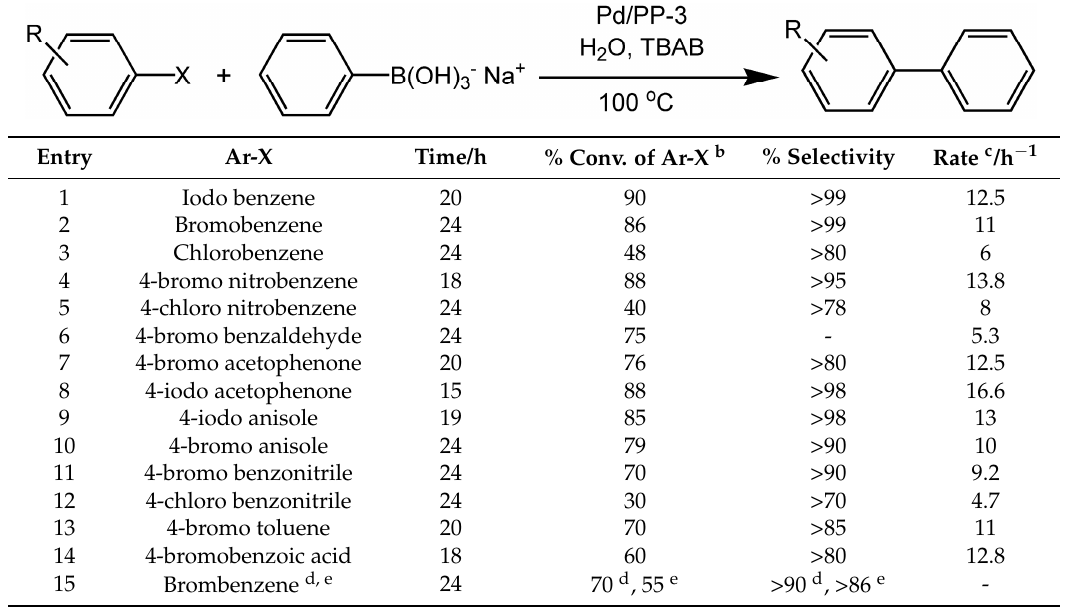
Figure 5. ( a ) Influence of reaction temperature; ( b ) Amount of catalyst on yield of biphenyl from bromobenzene; ( c ) Reaction profile/kinetic plot for bromoenzene conversion to biphenyl; ( d ) Plot of natural logarithm of the remained bromobenzene conc. during reaction with time. Table 2. Substrate scope of Suzuki coupling reaction by Pd/PP ‐ 3. a